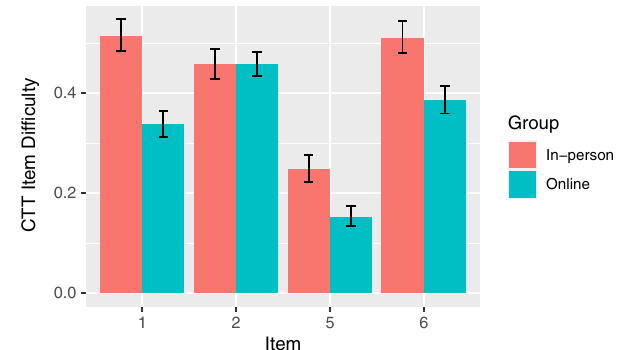
FIG. 6. Item difficulty for the PIQL ’ s four MCMR items with a single correct answer choice.